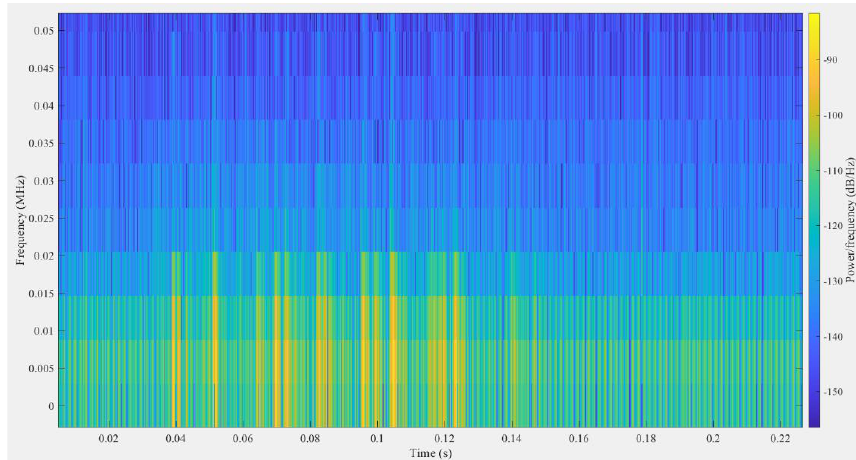
Figure 31. Time-frequency diagram of low frequency signal in S1 noise signal.